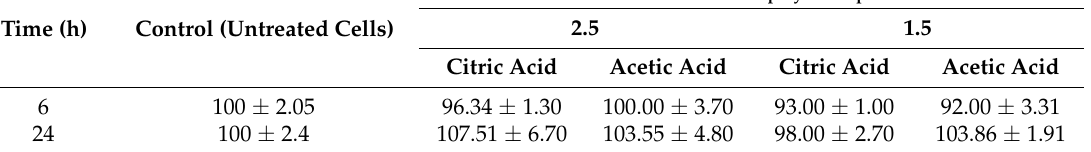
Table 3. The viability of SVEC4-10 cells exposed to unloaded nanogels compared to untreated cells measured by SRB assay. Results are expressed relative to the untreated cells (100%) and represented as average ± SD ( n = 3).